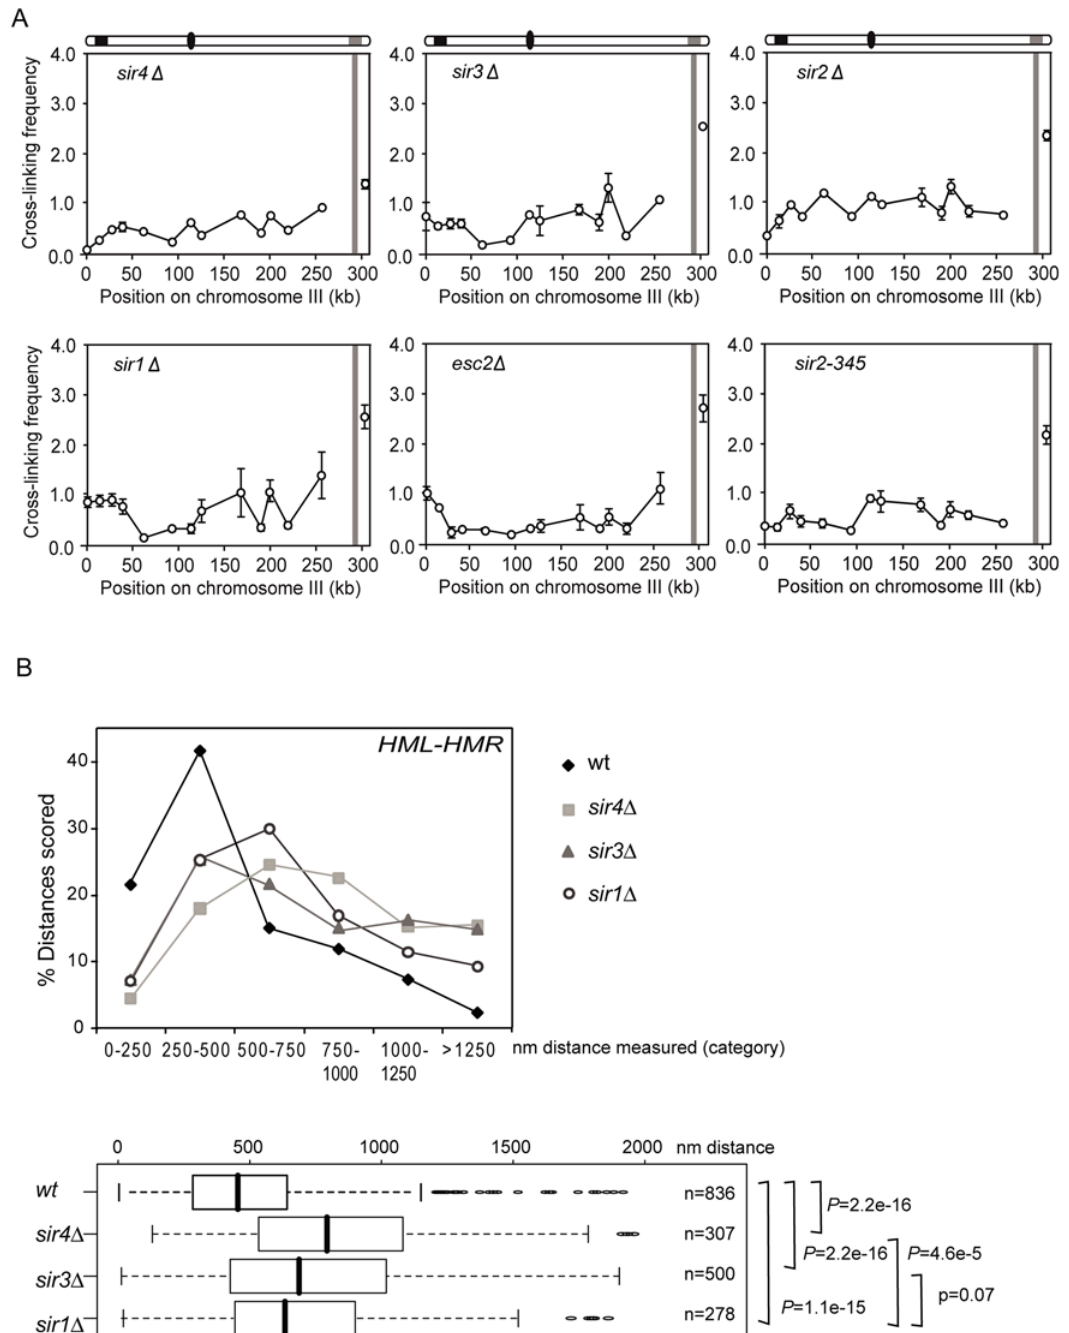
Figure 3. Role of silencing proteins in HM interactions. (A) Analysis of interactions in sir4 D , sir3 D , sir2 D , sir1 D , esc2 D and sir2-345 cells examining crosslinking frequencies between the Eco RI fragment containing HMR with other restriction fragments along the length of chromosome III. (B) 3D live cell analysis of HML-HMR colocalization in sir4 D , sir3 D , sir2 D and sir1 D cells. Image stacks were acquired as in Figure 1 and analyzed by the SpotDistance plug-in of ImageJ. R software was used for the representation of distance distributions as a box plot. Outliers are defined as 1.5 times the Inter Quartile Range (IQR) and are represented as open circles. Distance frequencies were compared using a Wilcox test.